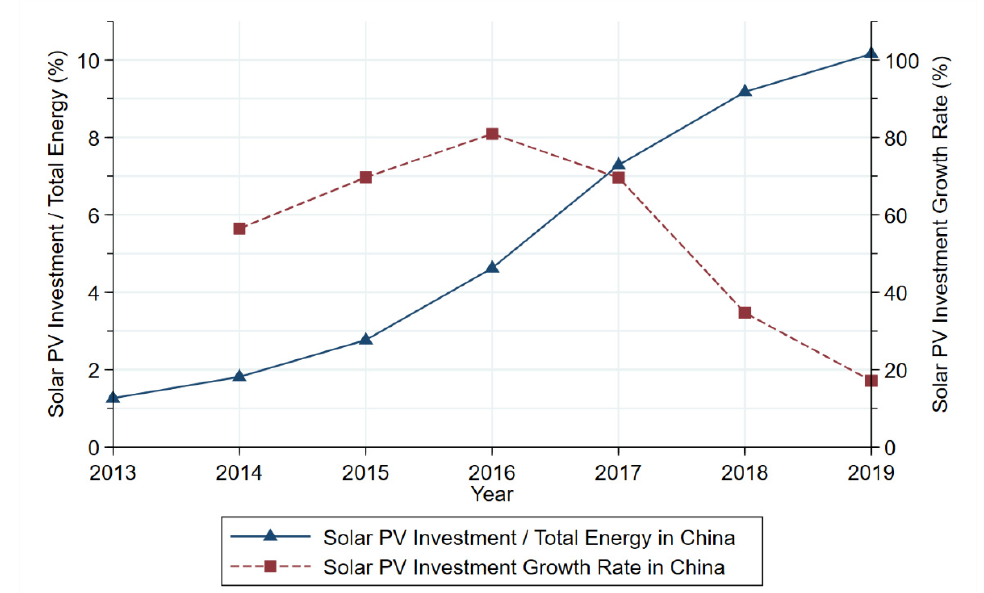
Figure 1. The proportion of solar PV investment to total energy investment and solar PV investment growth rate, 2013–2019.